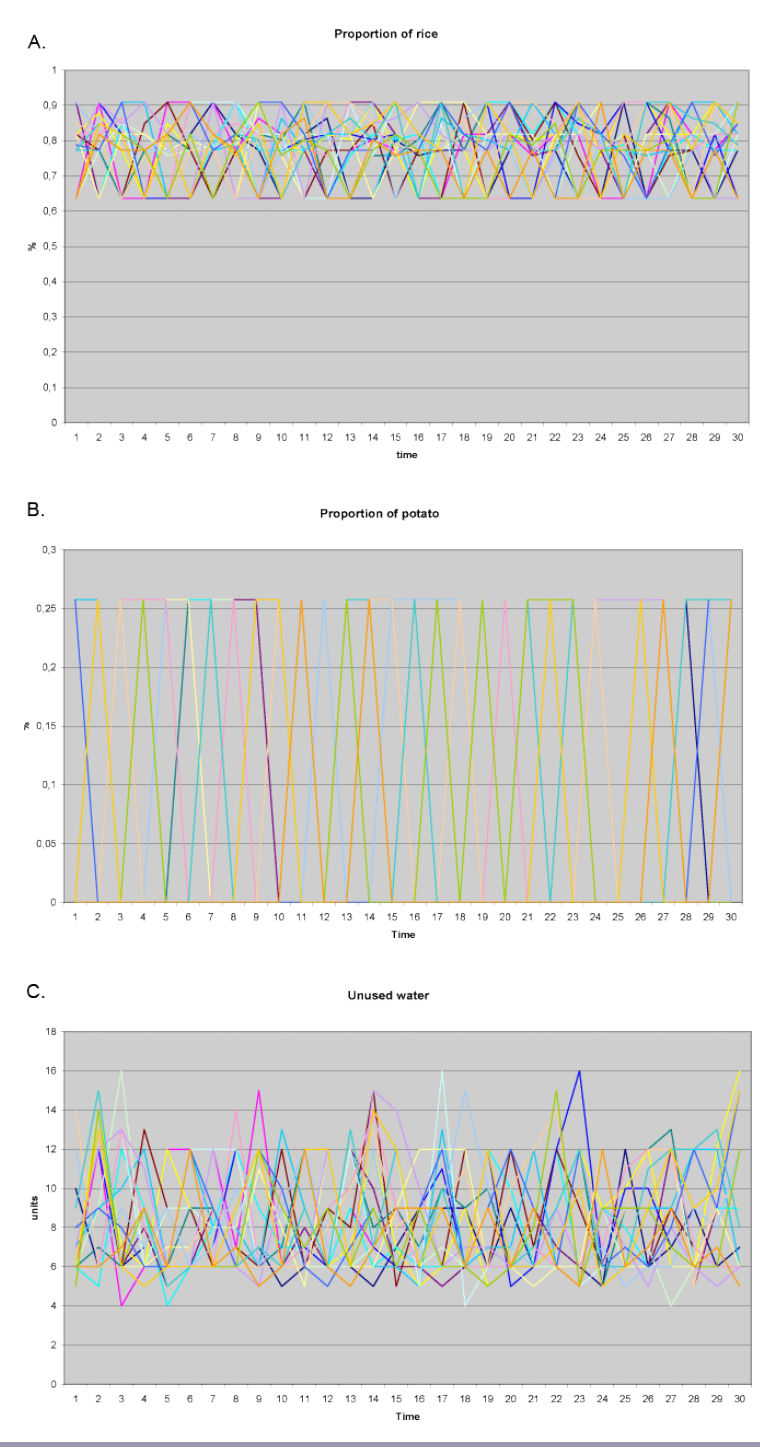
Fig. 6. Test of the Limbukha base model indicating (a) rice plots, (b) potato plots, (c) unused irrigation water, generated from 30 simulations of the base